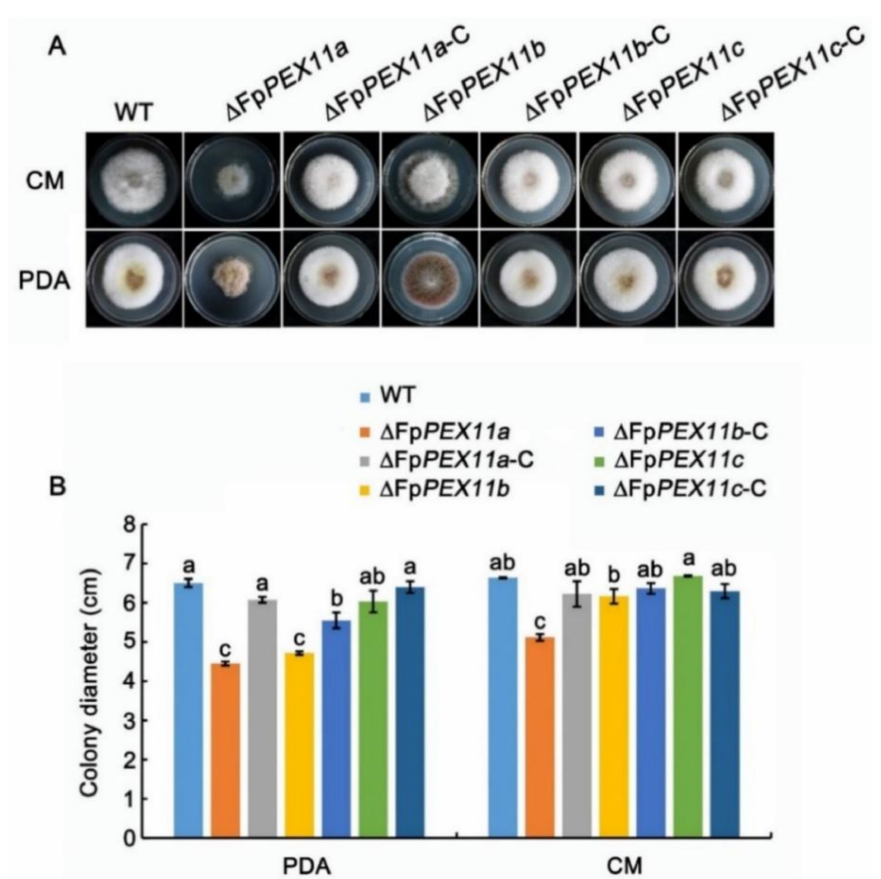
Figure 2. Phenotypic test assay for WT, ∆ FpPEX11, and ∆ FpPEX11-C strains in F. pseudograminearum . ( A ) Mycelial growth of all strains on PDA and CM medium for 3 days. ( B ) Strain colony diameter statistics. Different letter on the bars for each treatment indicate significant difference at p < 0.05 by Duncan’s multiple range